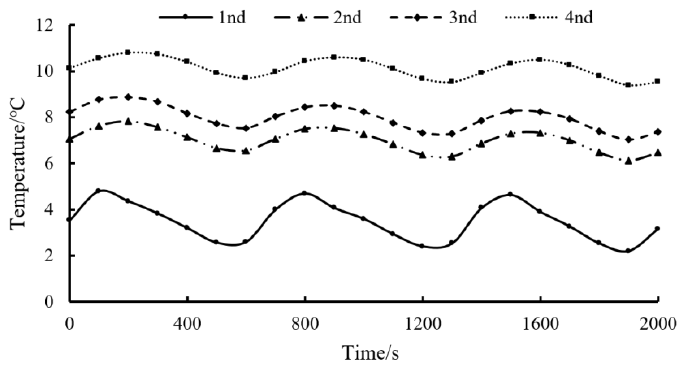
Figure 3. Periodic variation in the temperature on each shelf (0% aperture